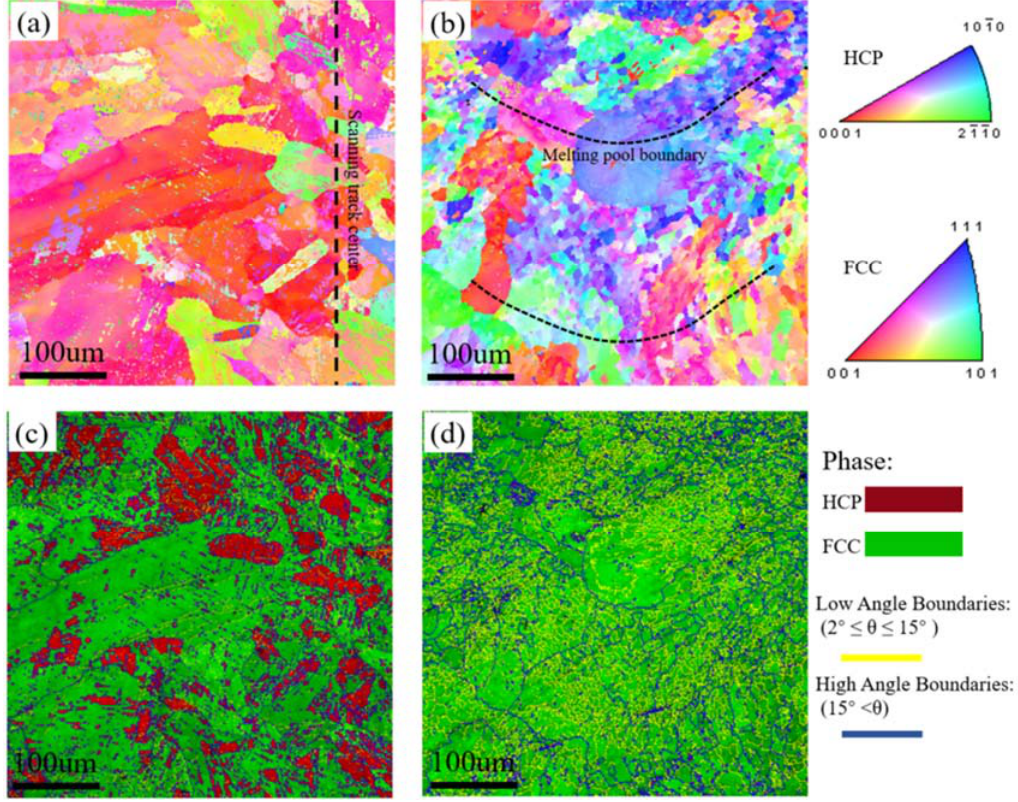
Figure 3. EBSD inverse pole figures (IPFs) and IQ + phase maps of the LMD sample: ( a , c ) XY ‐ plane and ( b , d ) YZ ‐ plane.